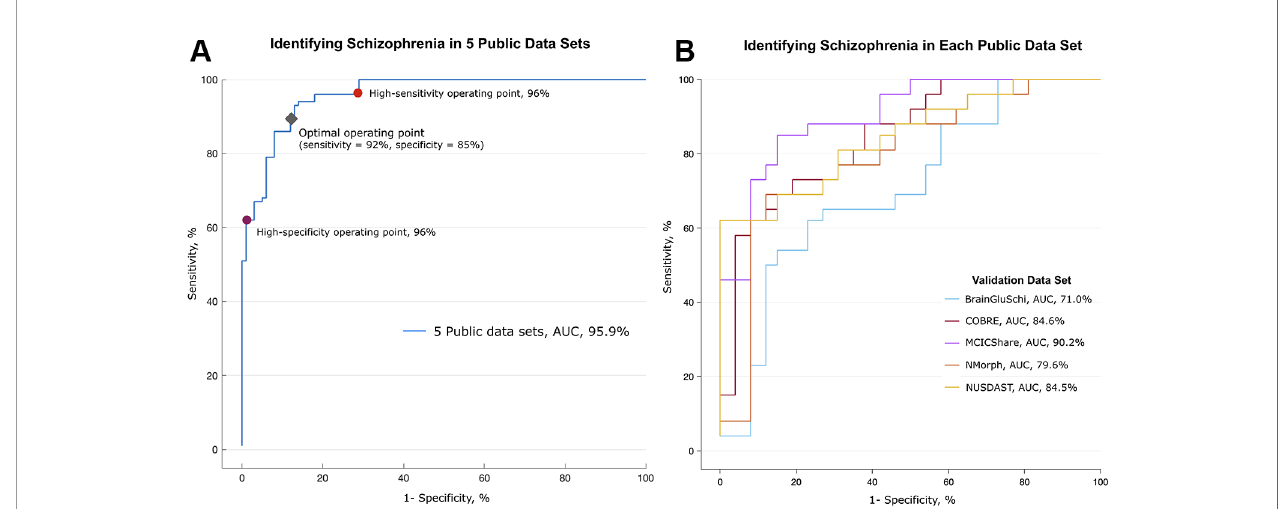
FIGURE 2 | Performance in detecting schizophrenia in fi ve public MRI data sets. Performance in identifying schizophrenia in fi ve publicly available MRI data sets. (A) The deep learning algorithm was trained with 693 randomly selected images (80% of all images) and discriminated between patients with schizophrenia and normal subjects in the remaining 173 MR images. This process was repeated 10 times (10-fold cross-validation). The area under the receiver operating characteristic (ROC) curve (AUC) was 0.959. The red and purple circles on the graph represent optimal operating points; the sensitivity was 96% and the speci fi city was 96% at these points, respectively. The gray diamond represents the optimal operating point, which had 92% sensitivity and 85% speci fi city. (B) Validation of algorithm performance across the data sets. The deep learning algorithm was trained with MR images from four of fi ve data sets, and the remaining one data set was used as a validation set. The algorithm trained without the MCICShare data set showed the highest performance (red line, AUC of 0.902), and the algorithm trained without the BrainGluSchi data set showed the lowest performance (blue line, AUC of 0.710).